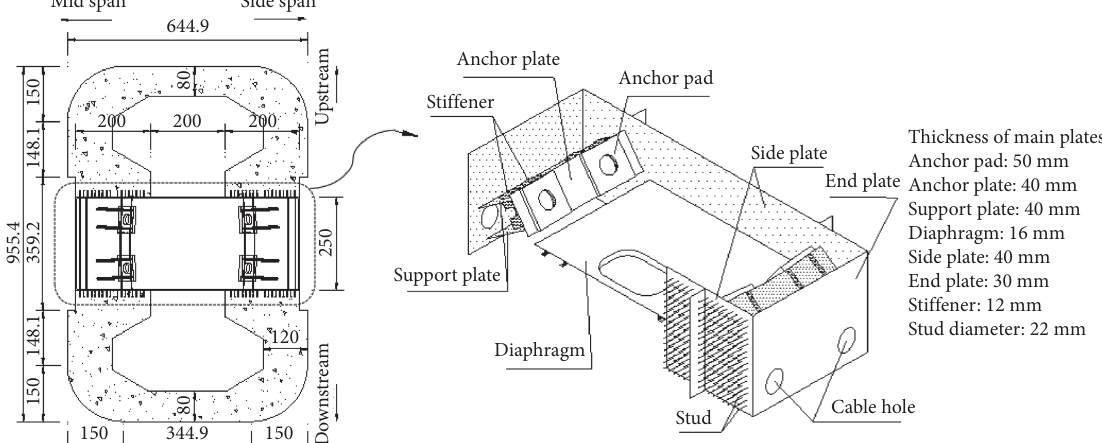
Figure 1: Tower anchor structure with an exposed steel anchor box (mm).